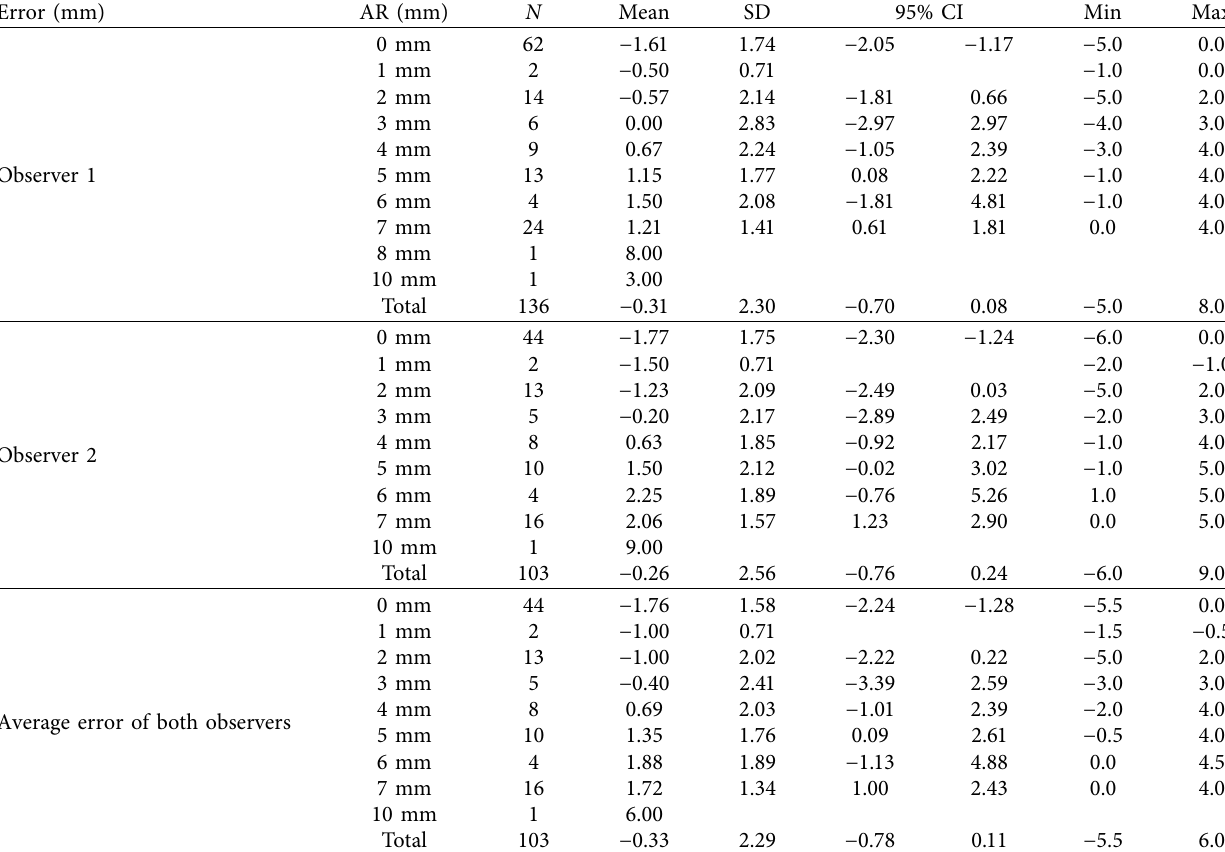
Table 2: Descriptive statistics and 95% CIs for the extents of error (mm, calculated as the actual resorption extent minus the radiographic resorption estimate) observed by each of the radiograph evaluators in the case of each of the extents of actual resorption (mm). Error